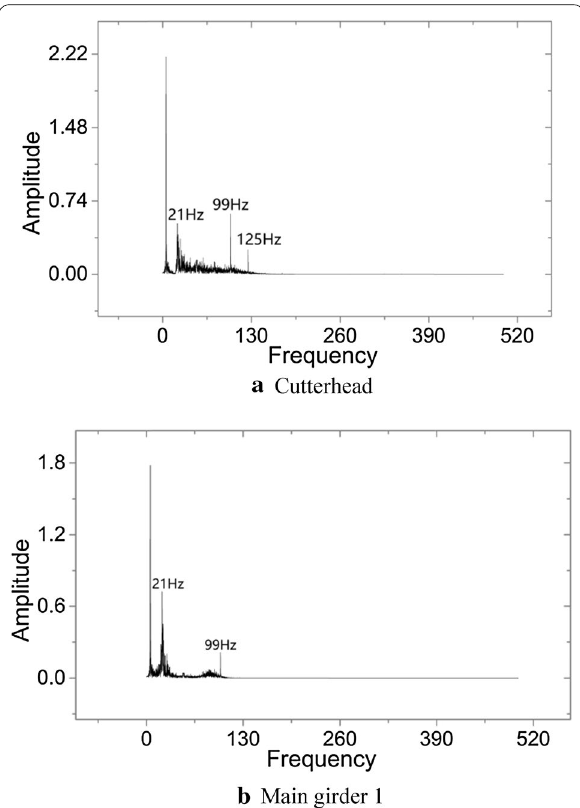
Figure 12 Frequency spectrum results in the lateral direction